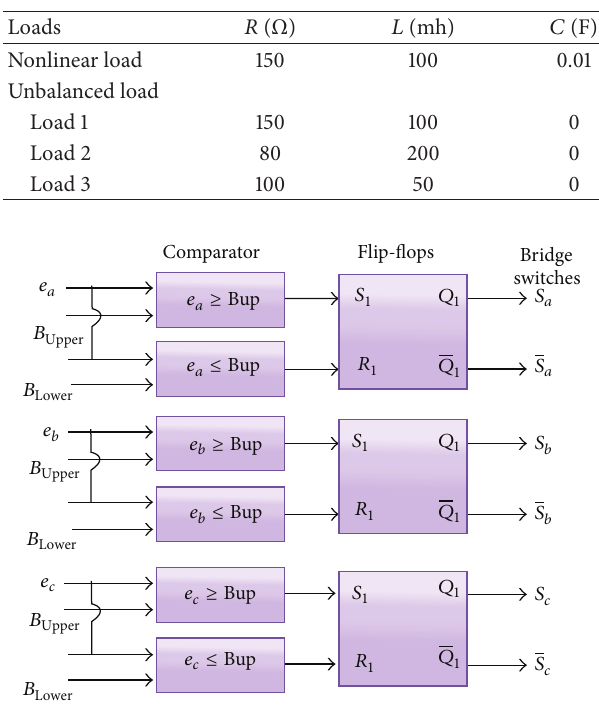
Figure 4: Simplified model of a fixed hysteresis-band